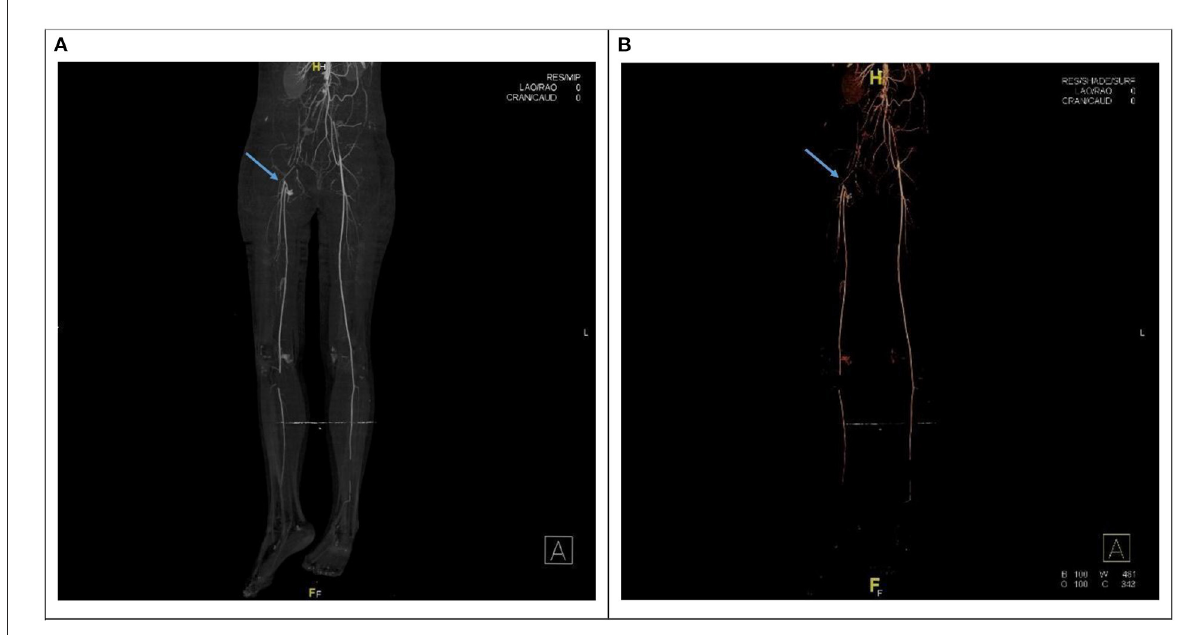
FIGURE1 (A,B) CT angiogram showing interruption of the contrast at the aorto-iliac arterial level correlated with embolization at the aortic bifurcation (saddle embolus) with thrombus propagation. The blud arrow point to no visualization of the right external iliac